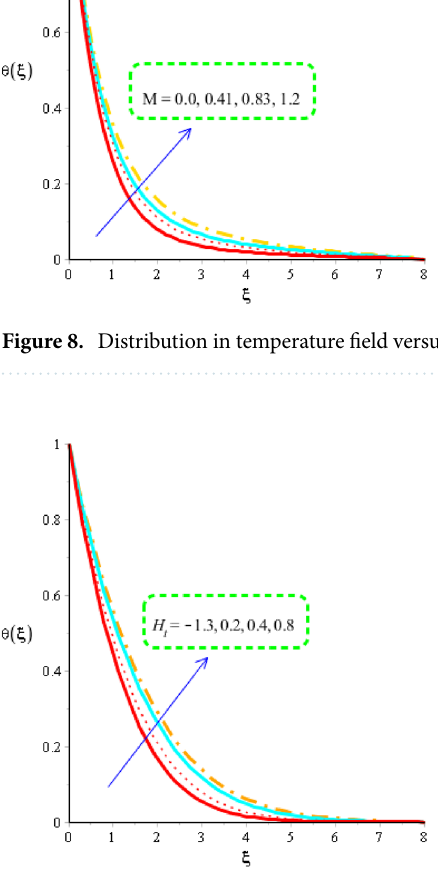
Figure 9. Distribution in temperature field versus H t